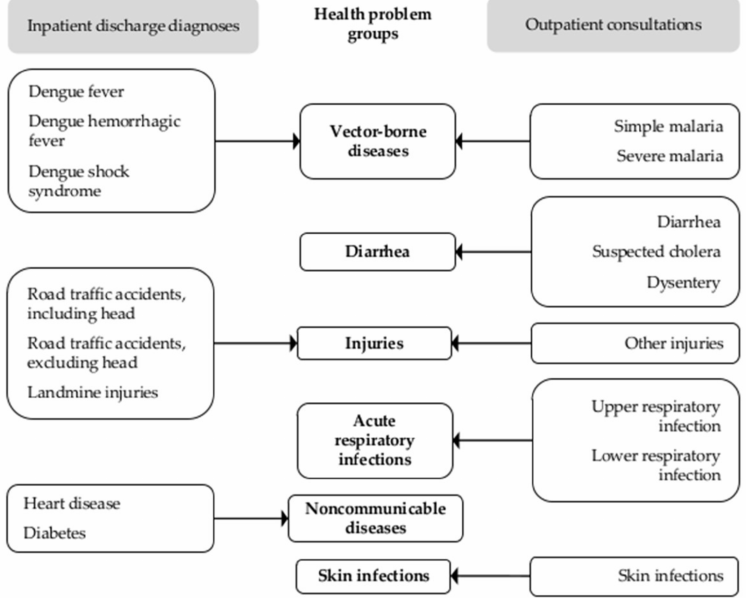
Figure 2. Inpatient discharge diagnosis and outpatient consultation data included in the health problem